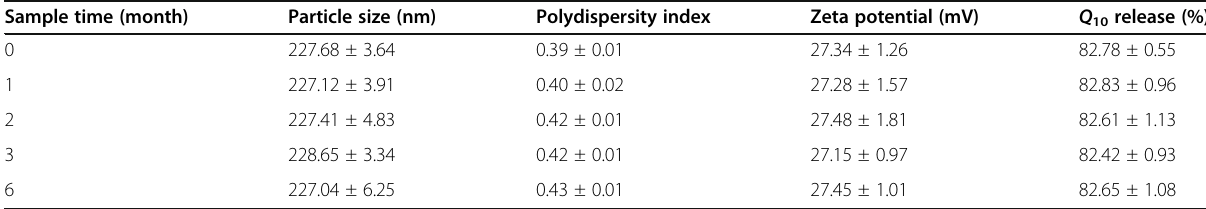
Table 6 Accelerated stability study evaluation data Sample time